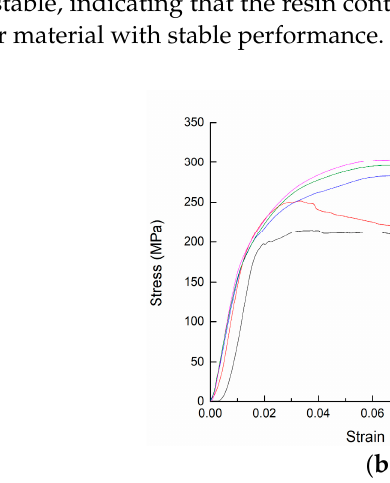
Figure 7. The bending stress-strain curve of 3DDAI Kevlar/EP armor materials with different contents of epoxy resin. ( a ) The warp direction. ( b ) The weft direction.